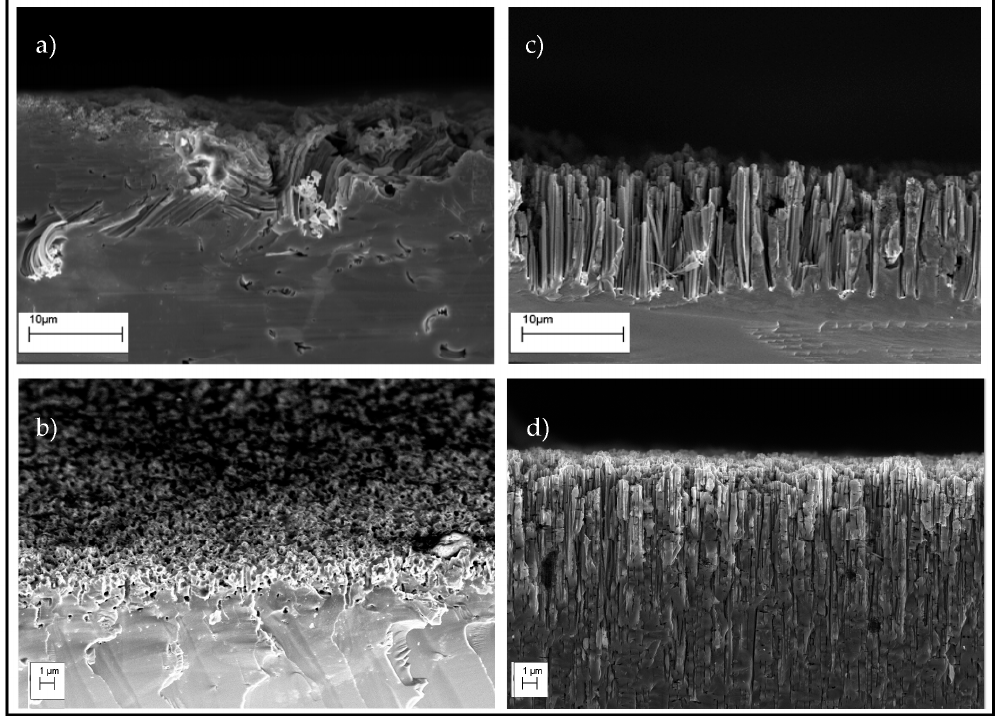
Figure 4. SEM images of the MaCE process of silicon in H 2 O:H 2 O 2 :HF solution, ( a ) 1 min etching in a volumetric ratio of (0:1:1). Etching in (80:55:5) solution for; ( b ) 1 min; ( c ) 10 min; ( d ) 30 min.